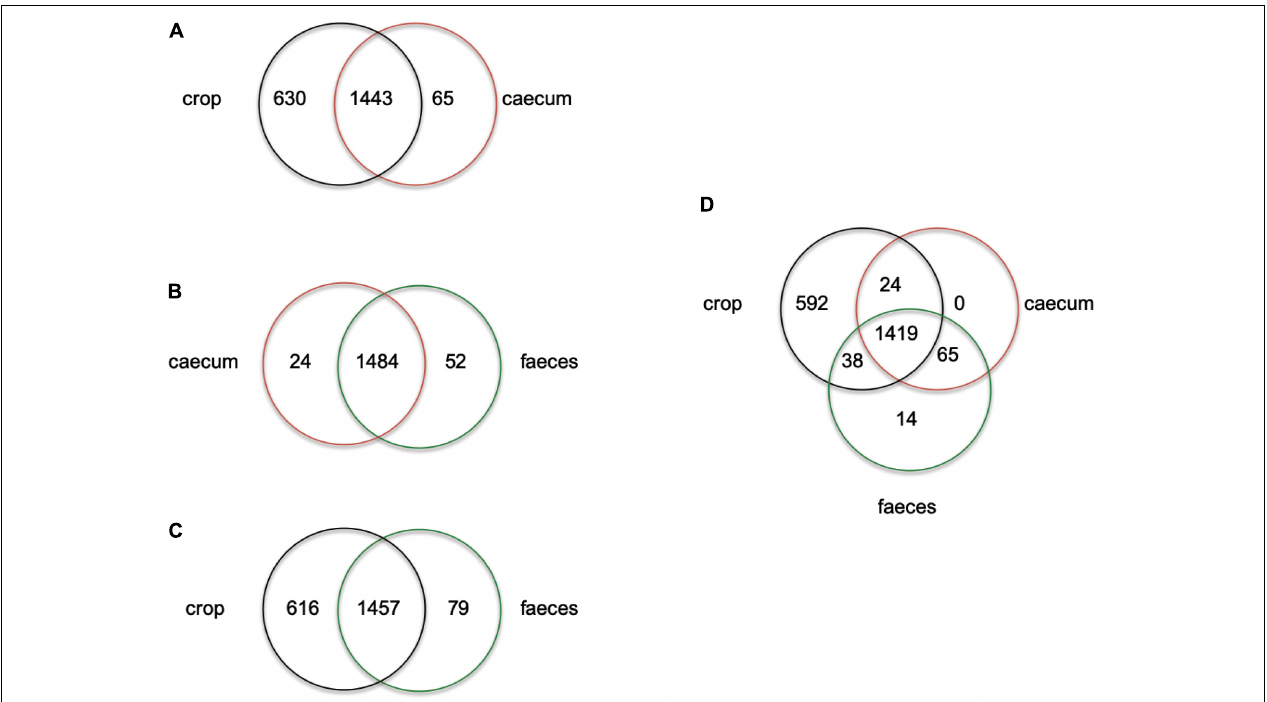
FIGURE 1 | Venn diagram showing the number of unique or shared genes between L. reuteri c hicken isolates from crop vs. cecum (A) , cecum vs. feces (B) , crop vs. feces (C) and cecum vs. feces vs. crop (D) . Individual unique genes of crop isolates, in each comparison, are listed in Supplementary Table S2 in alphabetic order.